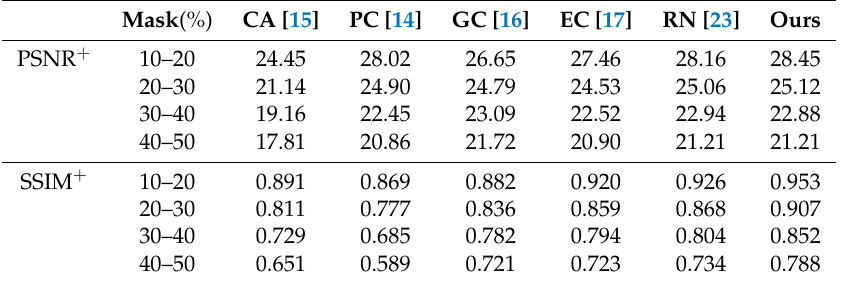
Table 6. Comparison results of different methods in terms of different ratios of mask on